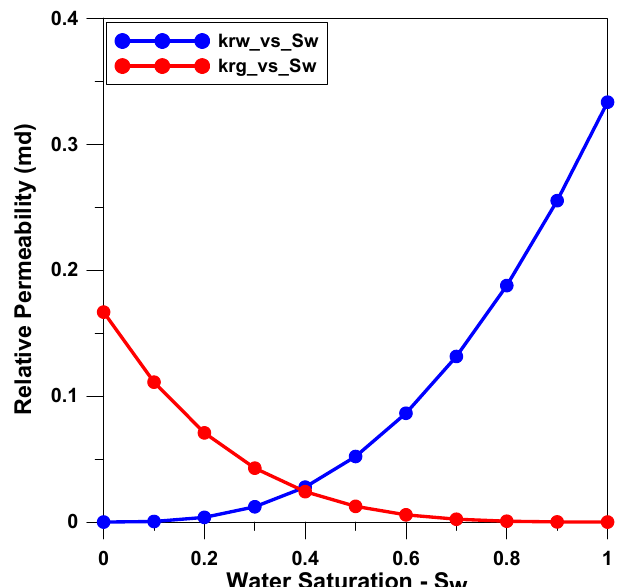
Figure 6. Relative permeability of hydraulic fractures.